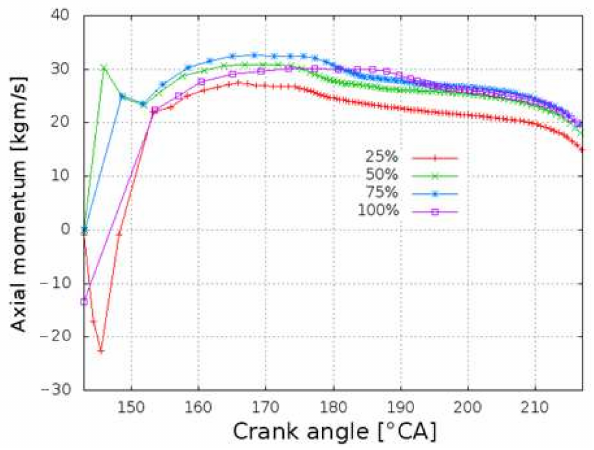
Figure 8. The variation of axial momentum over time for different engine